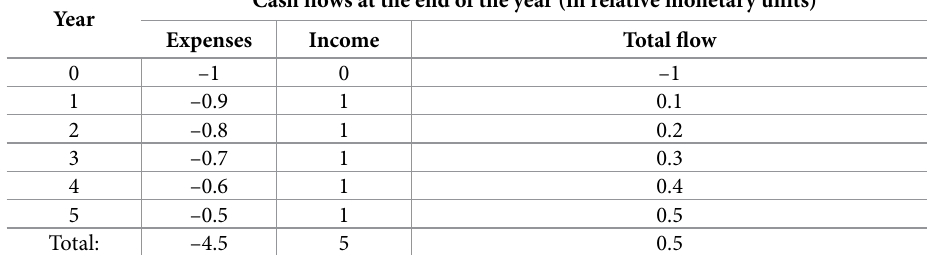
Table 1. Cash flows in project